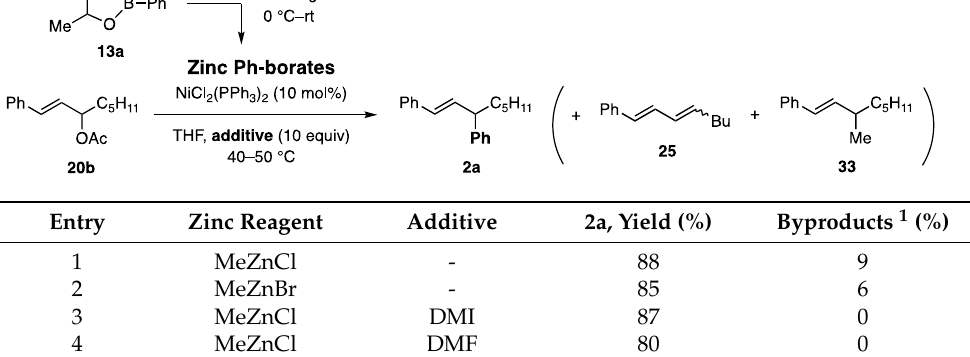
Table 2. Allylic coupling reaction with zinc phenylborates.